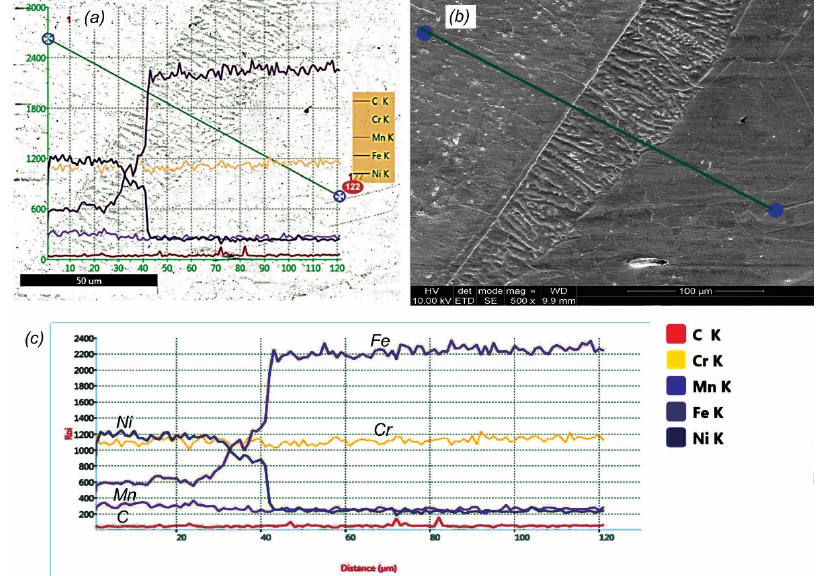
Figure 14. Results of EDS linear analysis for the zone: 304L austenitic stainless steel ( a ) distribution of elements against the background of the structure with the measuring line marked; ( b ) microstructure of the weld area–HAZ–304L austenitic stainless steel with the line according to which the elements were measured; ( c ) linear distribution of elements.